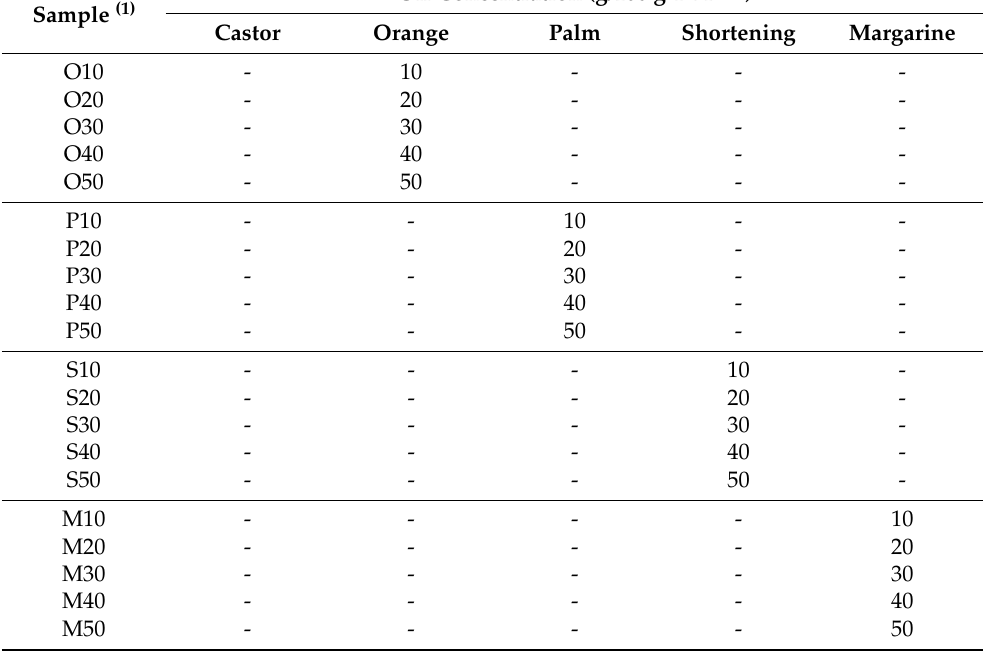
(1) SPI (soy protein isolate) and binder were added (4.5 g and 3 g, respectively, based on 100 g of TVP). (2) TVP stands for textured vegetable protein composed of Supromax 5050 ® and Supromax 5010 ®